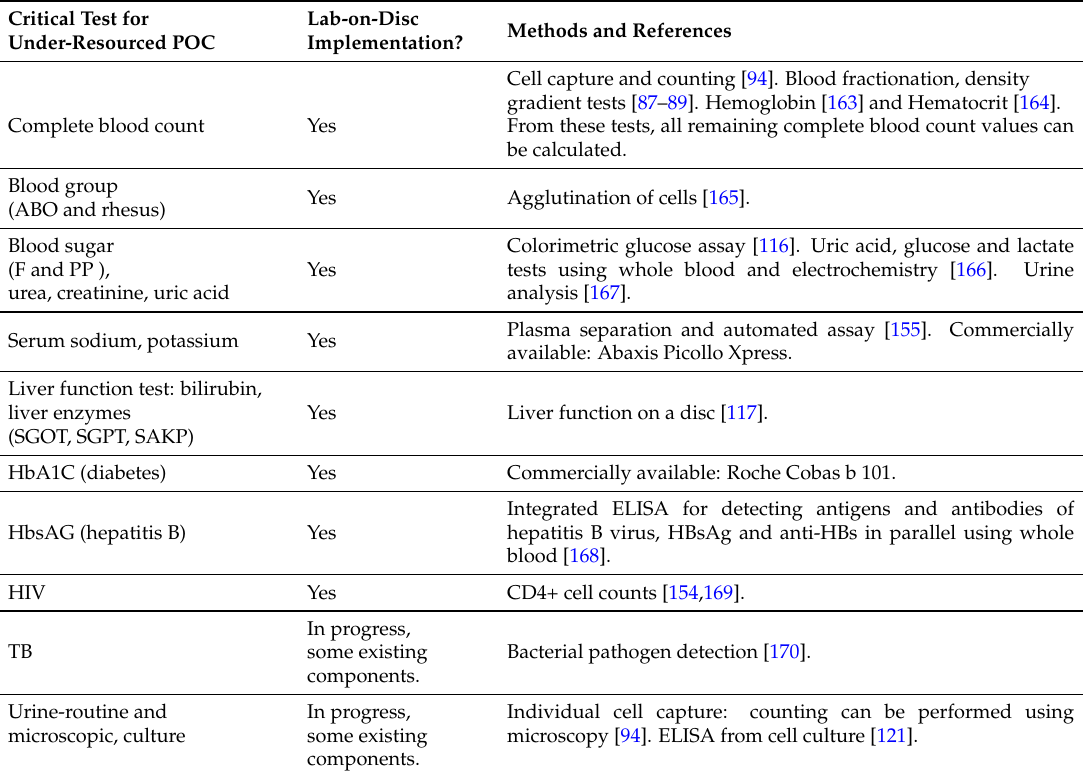
Table 5. Critical panel of tests required for effective POC diagnostics in extreme settings and corresponding existing CD-based versions. Additional tests for the critical panel that still require CD-based implementations included malaria, thyroid function test (T3, T4, TSH) and typhoid fever